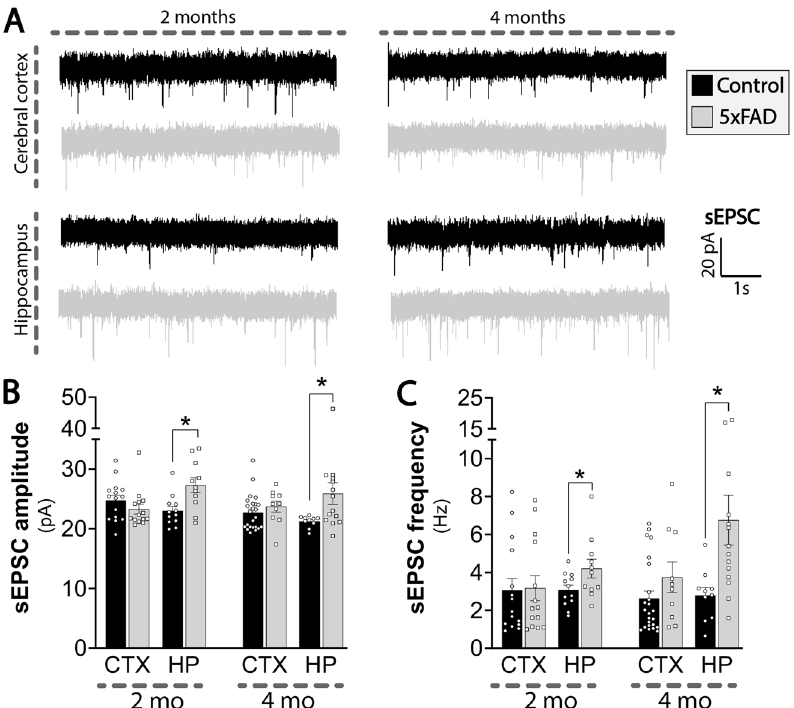
Fig. 2 Elevated spontaneous excitatory synaptic activity in 5xFAD hippocampal neurons. Neuronal signaling was assessed by whole-cell patch-clamp electrophysiology in brain slices of 2 and 4 months (mo) old 5xFAD and control mice. A Representative recordings of spontaneous excitatory post-synaptic currents (sEPSCs) (black traces: control, gray traces: 5xFAD). Quanti fi cation of amplitude ( B ) and frequency ( C ) in cerebral cortical and hippocampal slices of 2 and 4 mo old 5xFAD and control mice. sEPSCs were obtained in voltage-clamp, gap-free mode, with a voltage command set to − 60 mV. CTX: cerebral cortex, HP: hippocampus. Mean ± SEM, n = 10 – 24 from 4 – 6 pairs of animals, Student ’ s unpaired t -test or Mann-Whitney